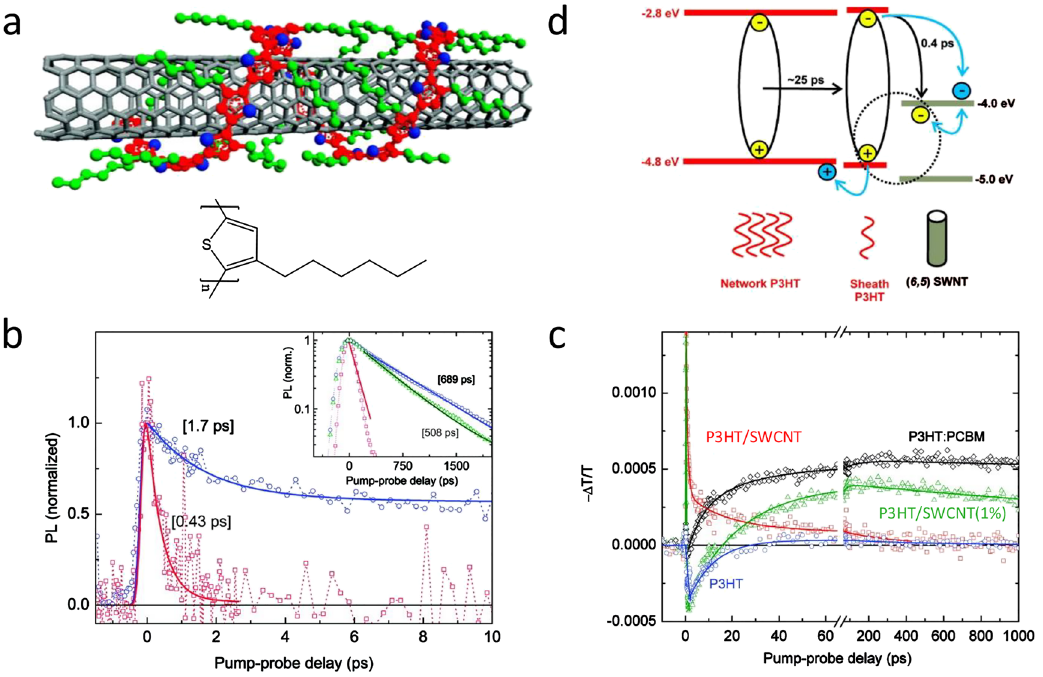
Figure4: (a)ChemicalstructureofP3HTandschematicdiagramof aSWCNT(6,5) coatedwithamonolayerof sheathP3HT;(b)The emissionof the P3HT (blue circles) was detected at 660 nm and P3HT/SWCNT (red squares) was detected at 620 nm after 400 nm excitation. Inset: TCSPC decay curves at the same probe wavelengths used for PLUC. The P3HT/SWCNT(1%) (green triangles) sample was also detected at 660 nm; (c) Kinetics obtained through fs-TA for the P3HT-PCBM (black diamonds), P3HT (blue circles), P3HT/SWNT (red squares) and P3HT/SWNT(1%) (green triangles) after irradiation by 400 nm and probed at 730 nm; (d) Scheme to illustrate the observed charge generation dynamics for a P3HT sheath monolayer around a SWCNT(6, 5) with an excess of P3HT acting as a surrounding network [53]. SWCNT, single-wall carbon